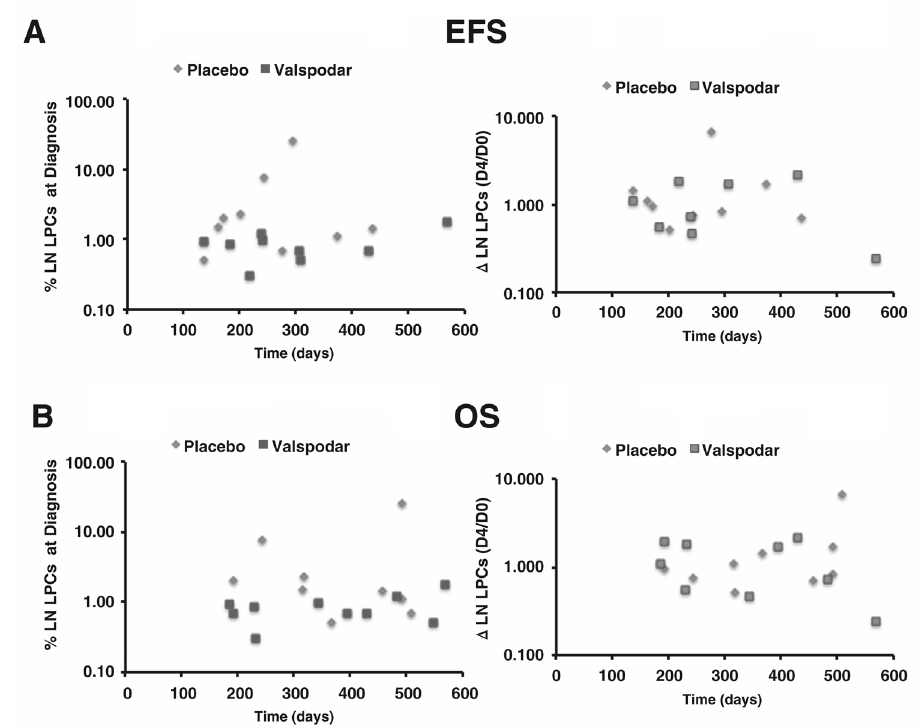
Figure 7. Event-free and overall survival of dogs as a function of lymph node LPCs from dogs with large B-cell lymphoma at diagnosis. ( A ) Dot plots showing the relationship between the percent of lymph node LPCs at diagnosis and EFS (N=9), and the relative change in LPCs from the time of diagnosis (Day 0) to the fourth day of the neoadjuvant period (Day 4) and EFS (N=8), in days in dogs treated with placebo (N = 9) or with neoadjuvant valspodar. ( B ) Dot plots showing the same relationships for overall survival (OS, N=9 and N=10 for LPCs at diagnosis and for Δ LPCs, respectively). Data were analyzed and graphs were assembled using MS